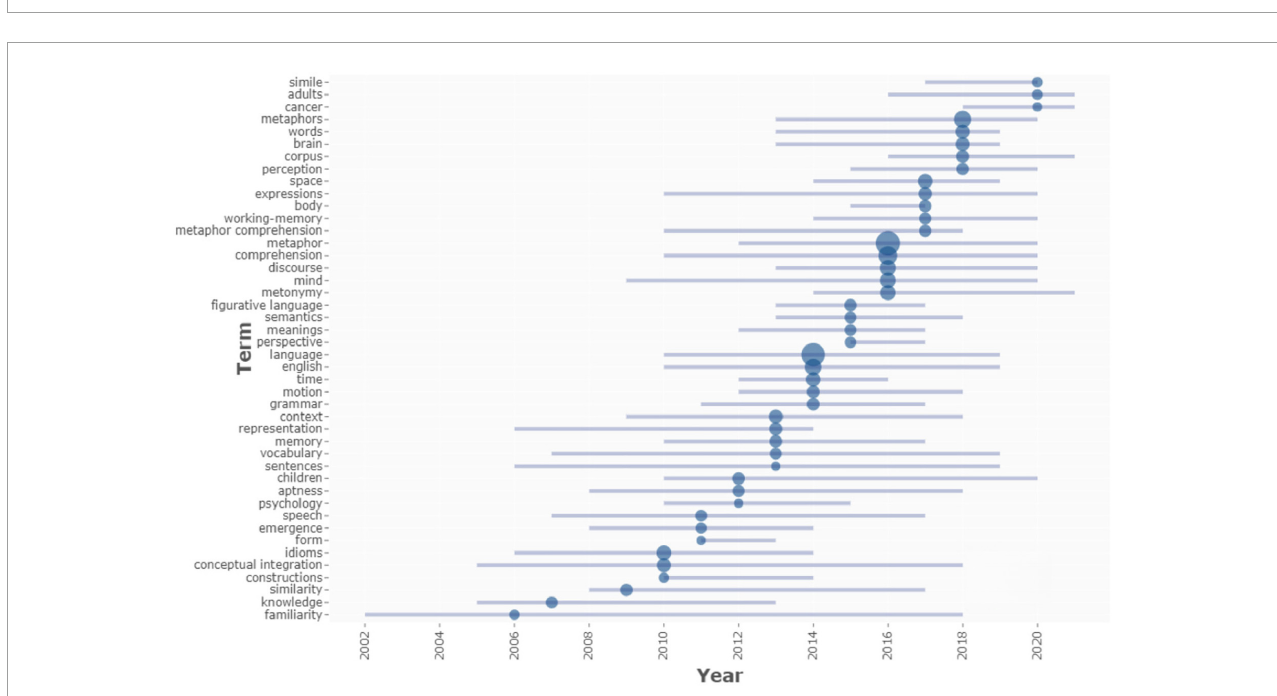
FIGURE14 Trend topics by keywords plus. The size of the nodes in Trend Topics represents the total number of publications for a particular topic and the peak popularity of that topic over